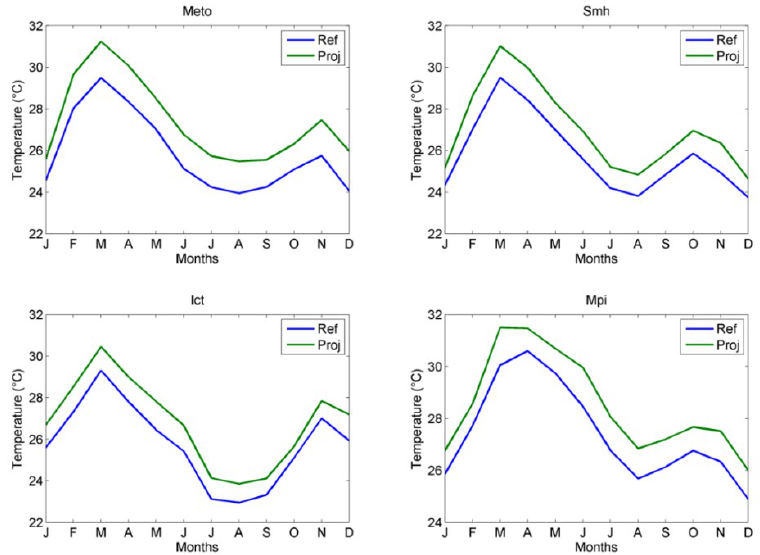
Figure 8. Projection of the monthly near-surface mean air temperature (2028–2050) and comparison to the reference period (1988–2010) for the four RCMs.